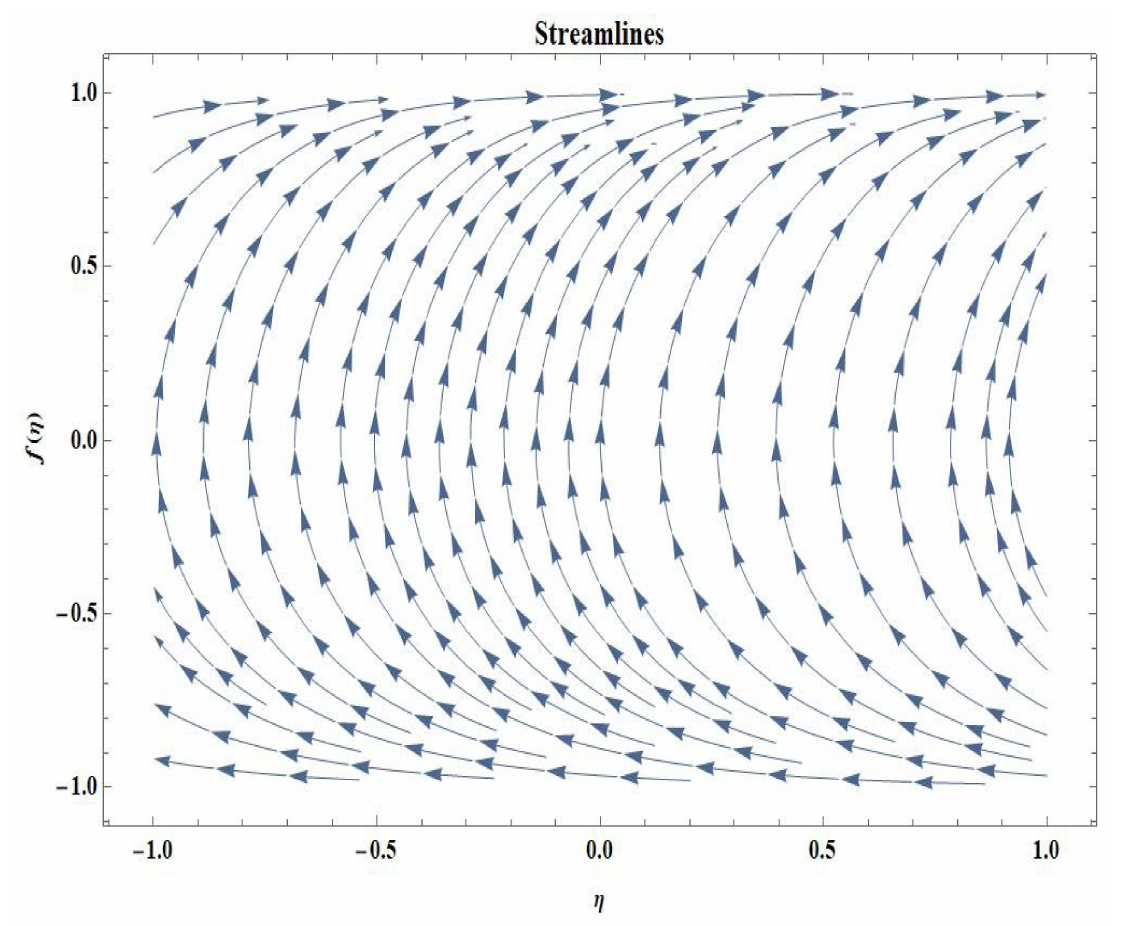
Figure 2. Streamlines of the present hybrid nanofluid